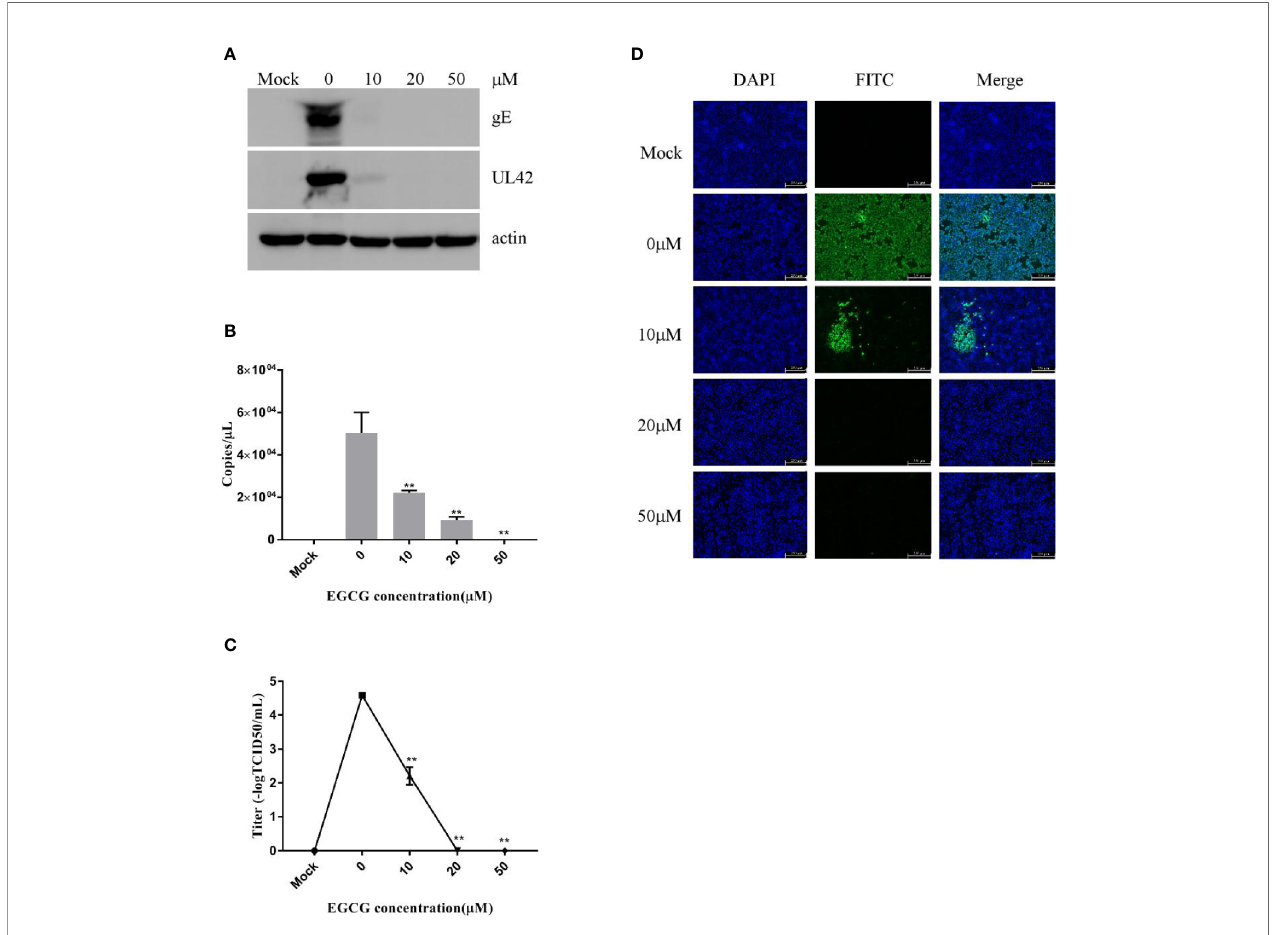
FIGURE 3 | ( – )-Epigallocatechin-3-gallate (EGCG) prevented pseudorabies virus (PRV) adsorption and entry to PK15 B6 cells. PK15 B6 cells were pretreated with 10, 20, or 50 m M EGCG for 1 h before cells were infected with PRV XJ5 (MOI=0.1) at 4°C for 1 h and then incubated with 10, 20, or 50 m M EGCG at 37°C for 1 h before removal of the EGCG medium and culture in EGCG-free DMEM. (A) At 24 hpi, Western blot detected PRV gE, UL42, and b -actin protein expression. (B) Intracellular virus DNA was quanti fi ed by qRT-PCR, (C) viral DNA titers were detected by 50% tissue culture infective dose (TCID 50 ) and (D) immuno fl uorescent assay (IFA) for internalized virus was performed. **p < ( Figure 3B ), with an EC 50 of approximately 9.6 m M. Together, these results con fi rmed that EGCG inhibited virus adsorption and entry in a dose-dependent manner, with 50 m M EGCG completely inhibiting PRV infection. Additionally, IFA assay further demonstrated that EGCG treatment prevented virion attachment and entry to cells in a dose-dependent manner ( Figure 3D ).